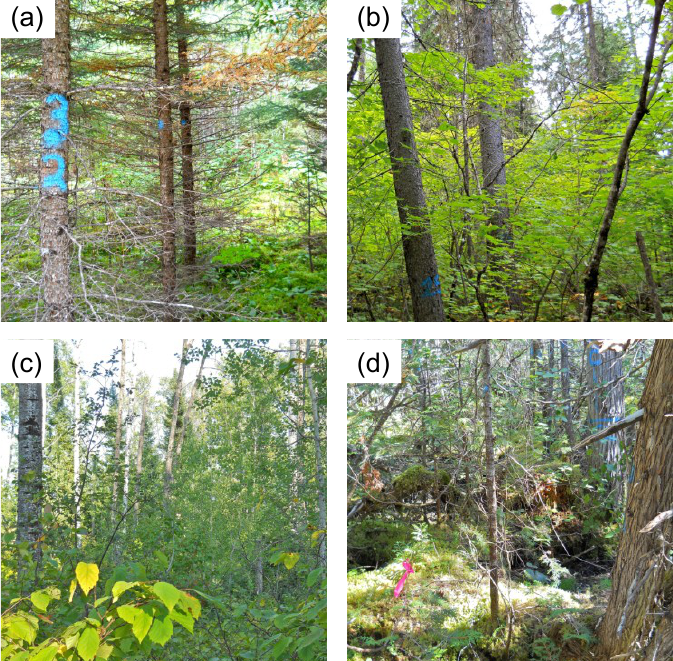
Figure 3. Examples of stands representing different ecosite classes. ( a ) B098: Fresh, silty to fine loamy, black spruce jack pine dominated; ( b ) B101: Fresh, silty to fine loamy, spruce-fir conifer; ( c ) B104: Fresh, silty to fine loamy, aspen-birch hardwood; ( d ) B128: Organic intermediate conifer